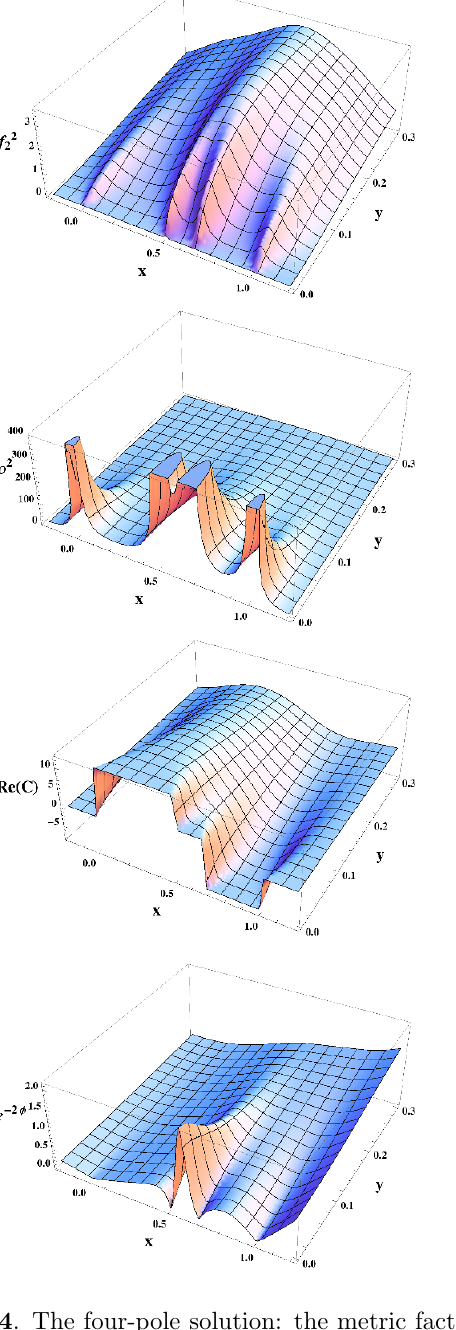
; f 2 , and (cid:26) 2 , the real and imaginary parts 2 6